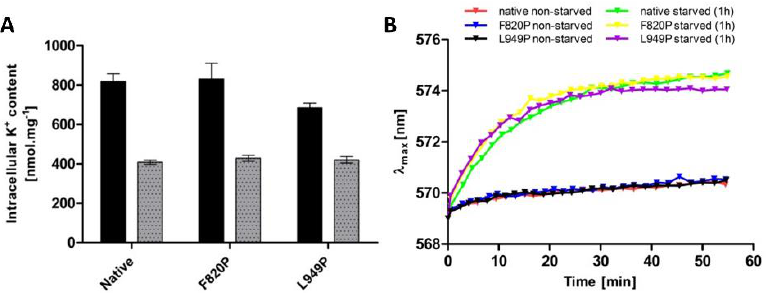
Figure 6. Intracellular K + content and relative membrane potential in BYT12 cells with native, L949P and F820P Trk1 versions. Cells were grown as described in Materials and Methods, and used directly (non-starved cells), or first incubated in a YNB-F for 1h (starved cells). ( A ) Intracellular K + content was estimated in non-starved (black columns) and starved (grey columns) cells as described in Materials and Methods. ( B ) Relative membrane potential was estimated as described in Materials and Methods.